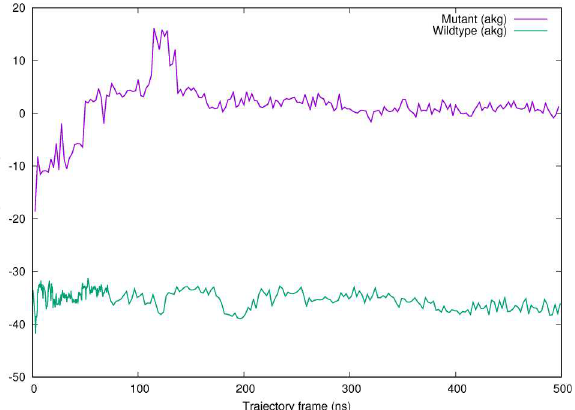
Fig 3. Average binding enthalpies for cosubstrate α -kg and Fe at the active site (in kcal/mol) for the simulation. Results for the product (succinate)are reported in the Supplementary